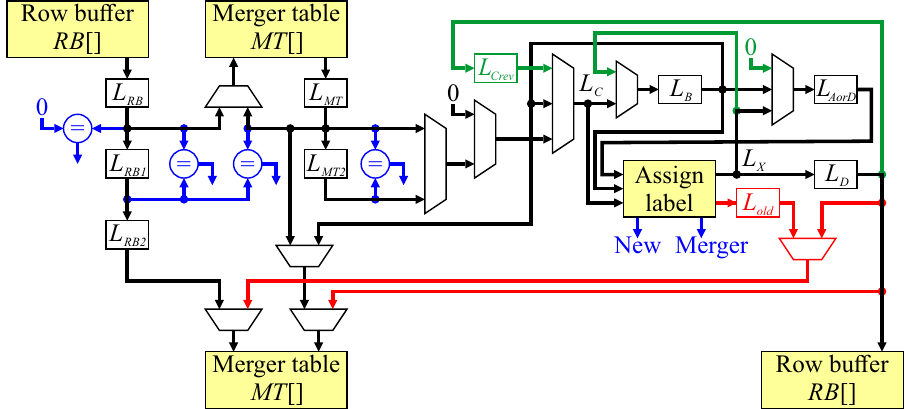
Figure 10. The detailed pipeline architecture for zig-zag connected components. Blue represents control signal generation, green indicates processing for end of row reversal, and red are the merger table updates for new label assignment and merger